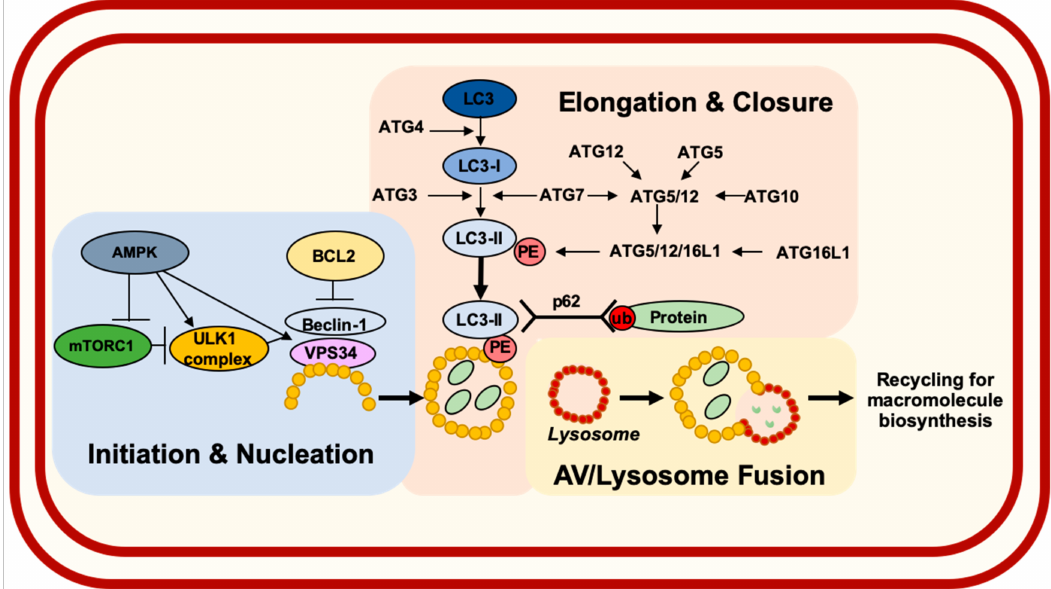
Figure 1. Molecular regulation of autophagy. Mammalian target of rapamycin 1 (mTORC1) acts a critical negative regulator of autophagy under nutrient-rich conditions. AMP-activated kinase (AMPK) serves a key positive regulator of autophagy in response to energy depletion. AMPK promotes AV initiation and nucleation through assembly of the Unc51-like kinase 1 (ULK1) complex. For nucleation to continue, Beclin-1 must dissociate from Bcl2 in order to interact with vacuolar sorting protein (VPS)34, a class III PI3 Kinase. AV elongation to surround p62 / SQSTM1-associated cargo proteins involves cleavage of Microtubule-associated protein light chain 3 (LC3) by autophagy-related (ATG)4, generating LC3-I. LC3-I is then lipidated (generating LC3-II) through addition of phosphatidylethanolamine (PE) by two ubiquitin-like conjugation systems consisting of various ATGs. Following closure, AVs undergo fusion with lysosomes where acid hydrolase enzymes break down autophagic cargo so that their constituents can be used for biosynthesis of